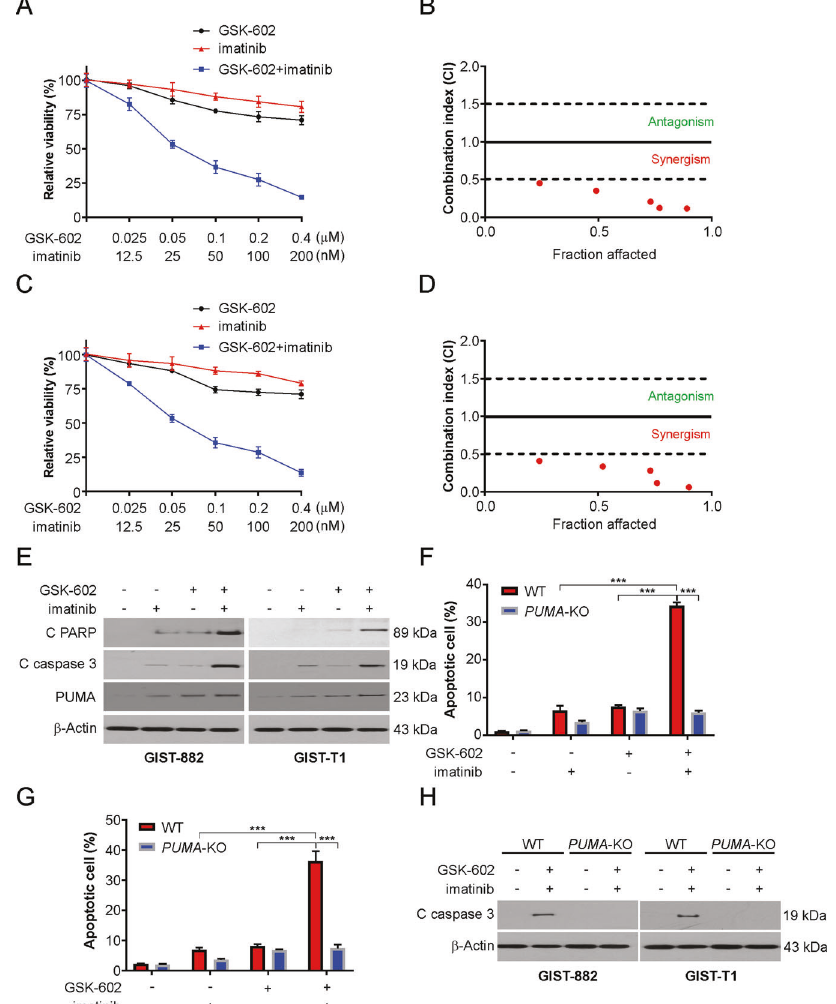
imatinib combining at different concentration in GIST-882 cells treated for 48 h were analyzed by the CompuSyn program (ComboSyn). C GIST-T1 cells were treated with GSK602 combined with imatinib at indicated concentration for 48 h. Cell viability was analyzed by MTT. D Combination index (CI) and fraction affected of GSK602 and imatinib combining at different concentration in GIST-T1 cells treated for 48 h were analyzed by the CompuSyn program (ComboSyn). E Indicated cells were treated with 100 nM GSK602 and 50 nM imatinib for 24 h. The indicated proteins were analyzed by western blotting. F WT and PUMA -KO GIST-882 cells were treated with 100 nM GSK602 and 50 nM imatinib for 24 h. Apoptosis was analyzed by fragment nuclei assay. G WT and PUMA -KO GIST-T1 cells were treated with 100 nM GSK602 and 50 nM imatinib for 24 h. Apoptosis was analyzed by fragment nuclei assay. H WT and PUMA -KO GIST-882 or GIST-T1 cells were treated with the combination of 100 nM GSK602 and 50 nM imatinib for 24 h. Caspase 3 level was analyzed by western blotting. Results were expressed as means ± SD of three independent experiments. *** P <